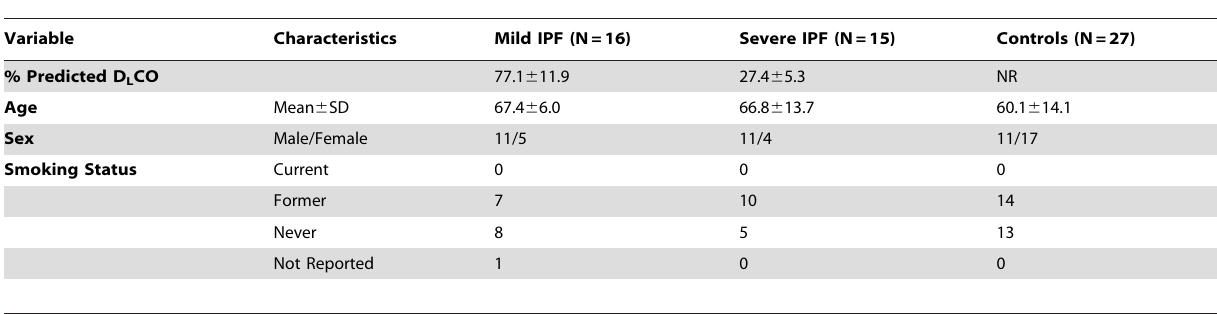
Table 2. Clinical and demographic IPF variables categorized by D L CO.